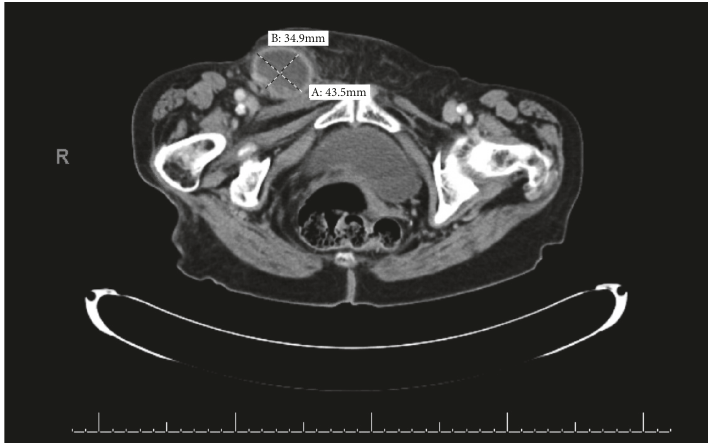
Figure 3: CT abdomen/pelvis image of right sided De Garengeot’s hernia with adjacent abscess measuring 4.3cm x 3.5cm